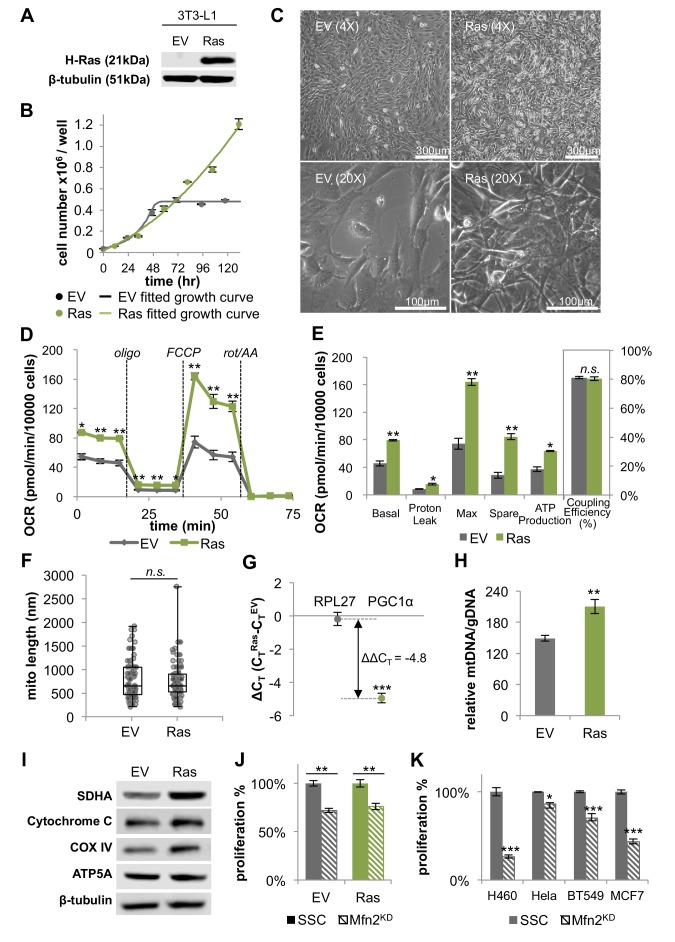
H-Ras transformed fibroblasts (Ras) have elongated mitochondria and increased OXPHOS that is supported by mitochondrial biogenesis.(A) Immunoblotting of whole-cell lysates shows H-Ras expression in transformed fibroblasts, but not in empty vector (EV) controls. (B) Growth curve shows the loss of contact inhibition in H-Ras transformed fibroblasts. The proliferation of EV controls remains cell-density dependent (n = 4). (C) Ras cells exhibit a morphological change and gain the ability to grow on top of each other to form multiple cell layers. (D) Mitochondrial stress test of EV controls and Ras cells (n = 3). The respiration of Ras cells is statistically increased compared to EV controls. (E) Measured and calculated parameters of mitochondrial respiration (using results from Figure 4D) (n = 3). (F) Statistical analysis of mitochondrial length in EV controls and Ras cells. In each condition, 100 random mitochondria were measured from EM images. Data are presented as mean ±SD. (G) RT-PCR shows that Ras cells have over a 20-fold increase in mRNA levels of PGC1α (n = 3). (H) Ras cells have increased mitochondrial mass, as indicated by an increased mtDNA/gDNA compared to EV controls (n = 3). (I) Immunoblotting of whole-cell lysates shows that Ras cells have higher expression levels of ETC subunits compared to EV controls. (J) Mfn2 knockdown decreases cellular proliferation in both EV controls and Ras cells. Proliferation was assessed by manual counting after cells were treated with scrambled siRNA control (SSC) or Mfn2 siRNA (Mfn2KD) for 72 hr. Relative proliferation was normalized to either an EV SSC or a RAS SSC for each condition (n = 4). (K) Mfn2 knockdown decreases cellular proliferation in H460 (lung cancer cells), HeLa (cervical cancer cells), BT549 (breast cancer cells), and MCF7 (breast cancer cells). Proliferation was assessed by using a CyQUANT proliferation assay after cells were treated with scrambled siRNA control (SSC) or Mfn2 siRNA (Mfn2KD) for 72 hr (n = 5). Unless specified, data are presented as mean ±SEM. *p<0.05, **p<0.01, ***p<0.001, n.s. not statistically significant. OCR, oxygen consumption rate; oligo, oligomycin; rot, rotenone; AA, Antimycin A.